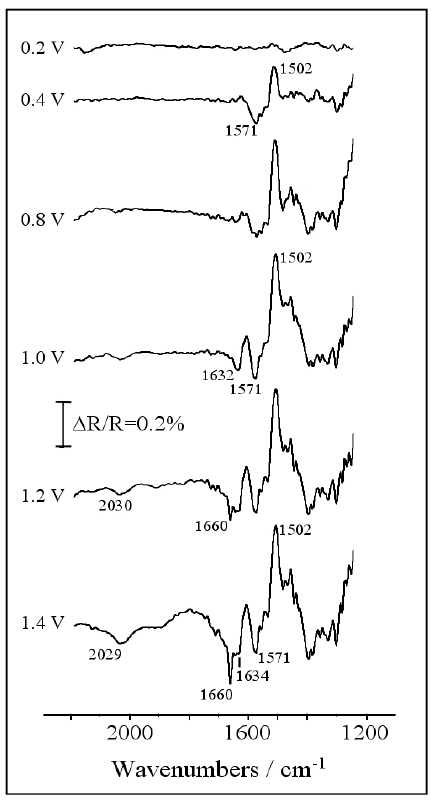
Figure 2. Set of in situ Fourier transform infrared (FTIR) spectra collected during the oxidation of 10 mM of piperazine in 0.1 M of HClO 4 /D 2 O solution. Reference potential: 0.1 V. Sample potential labeled for each spectrum: 100 interferograms at each potential.